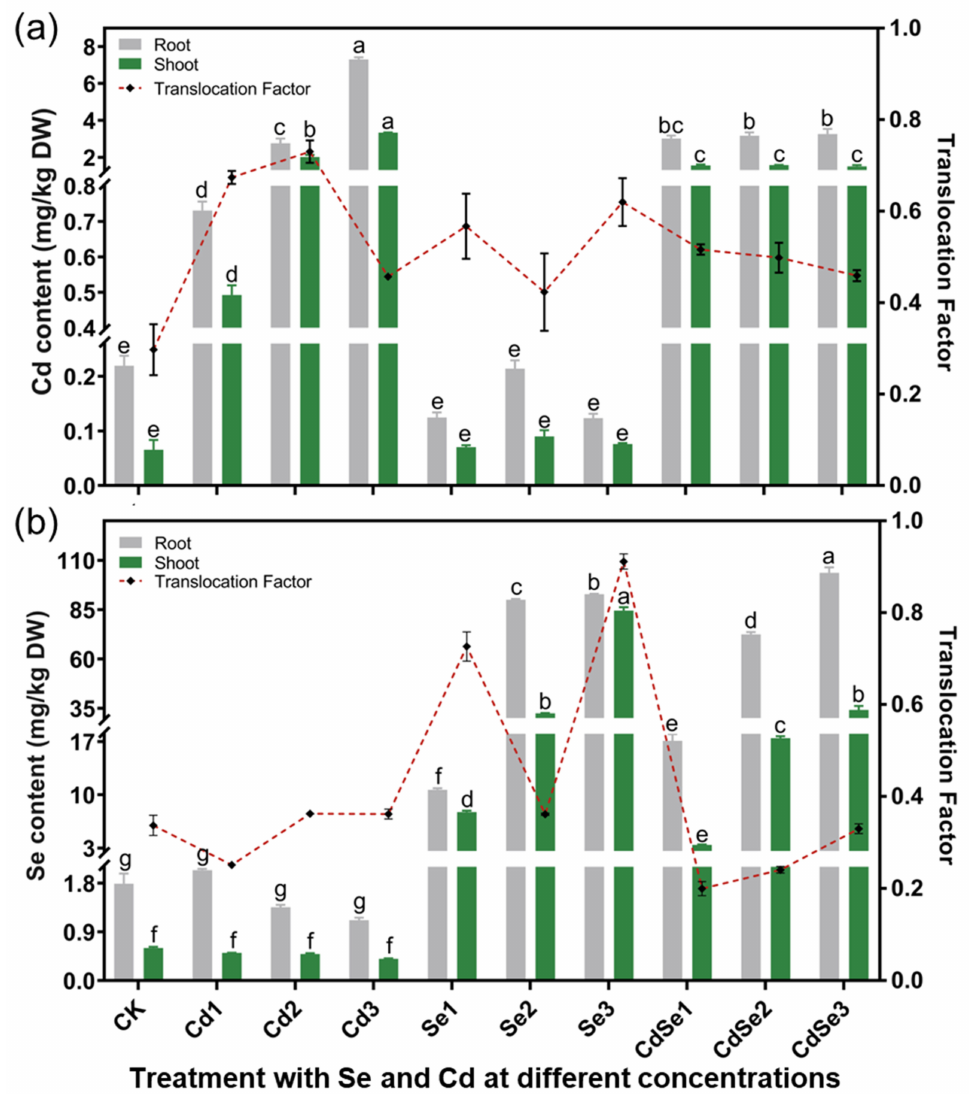
Figure 6. Content distribution and transfer efficiency of Se and Cd in the shoots and roots of B. juncea after treatment with different concentrations of CdCl 2 and Na 2 SeO 3 . The error bar represents the standard deviation. The lowercase letter a to g on the bar reflects the 5% significance levels. ( a ) The content and transfer rate of Cd in the shoots and roots; ( b ) the content and transfer rate of Se in the shoots and